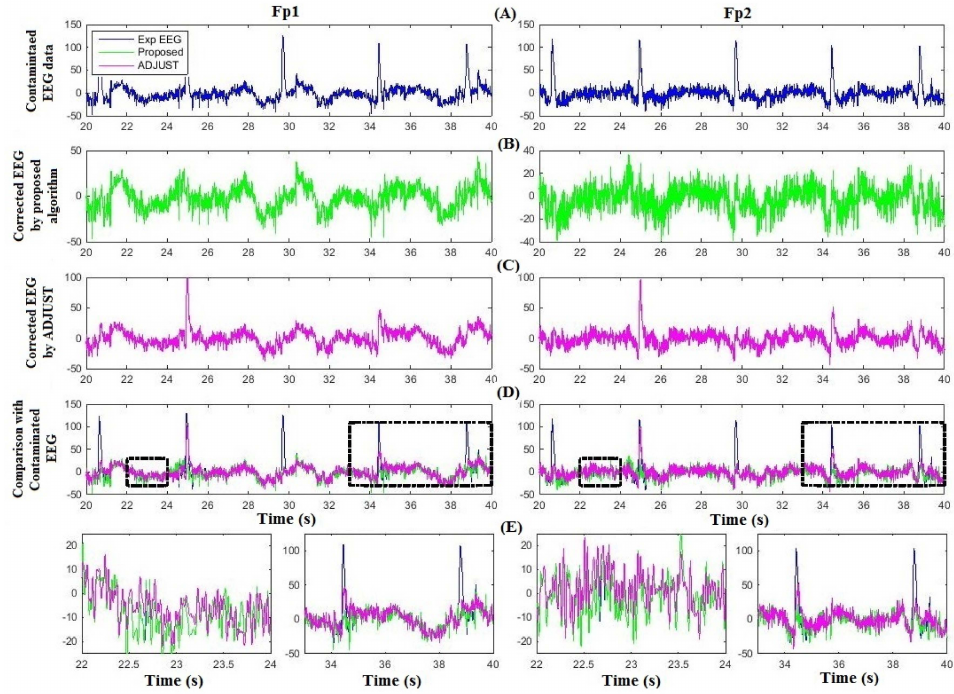
Figure 10. Comparison of the proposed algorithm with ADJUST using standard data. algorithm. ( C ) Corrected EEG by ADJUST. ( D ) Comparison of Corrected EEG with contaminated experimental EEG. ( E ) Partial enlargement of highlighted